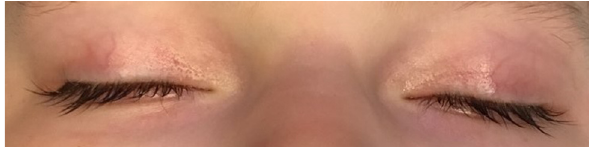
Figure 4: Right fundus photography of a girl with Cohen syn - drome – note eyes pale optic discs and “ salt and pepper ”